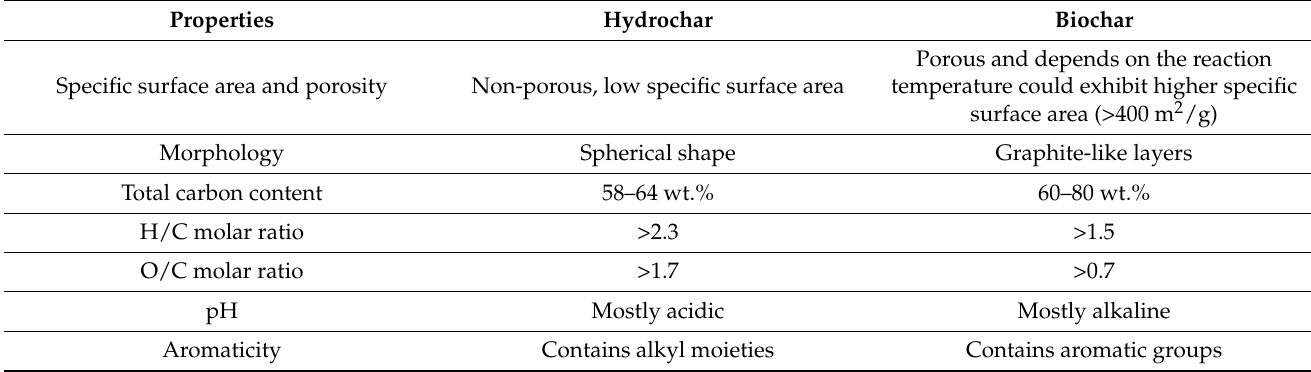
Table 1. Comparison of physicochemical properties of hydrochar and biochar [31,32,34]. Properties Hydrochar Biochar Porous and depends on the Non-porous, low specific surface area